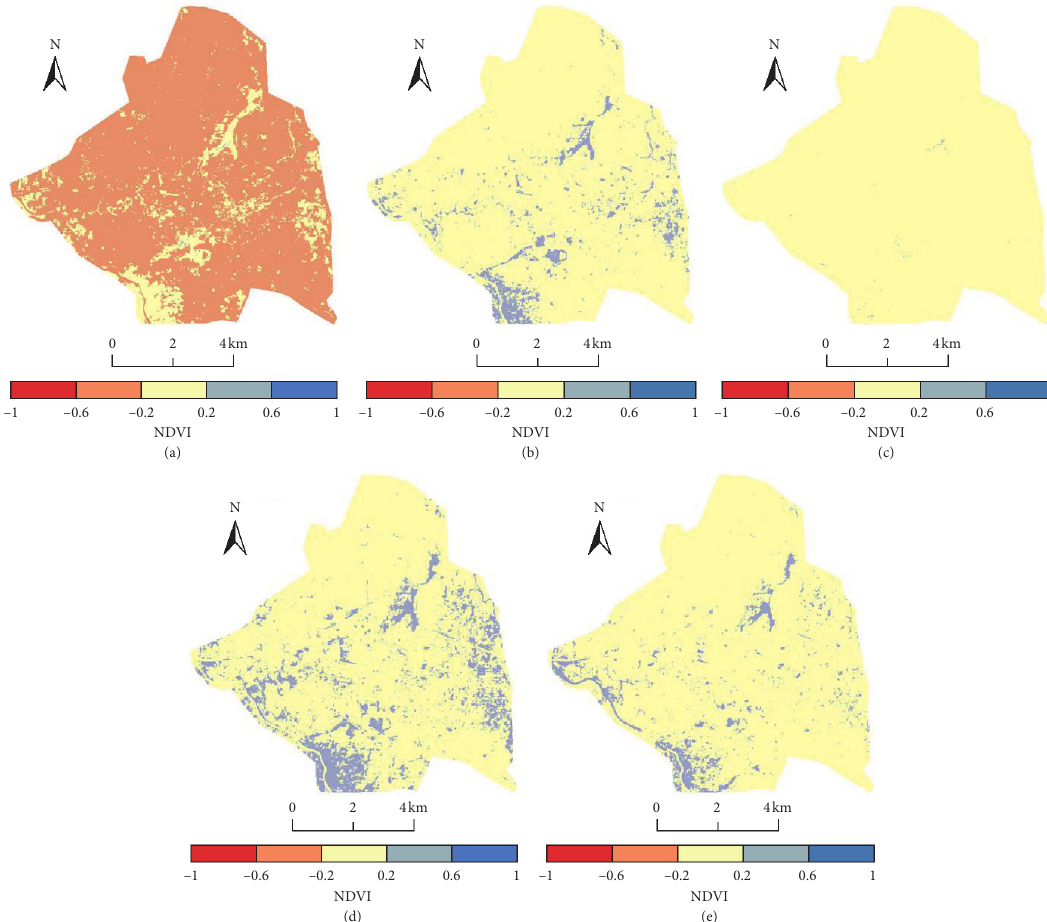
Figure 5: Distribution of mean NDVI: (a) 2002, (b) 2006, (c) 2010, (d) 2014, and (e)